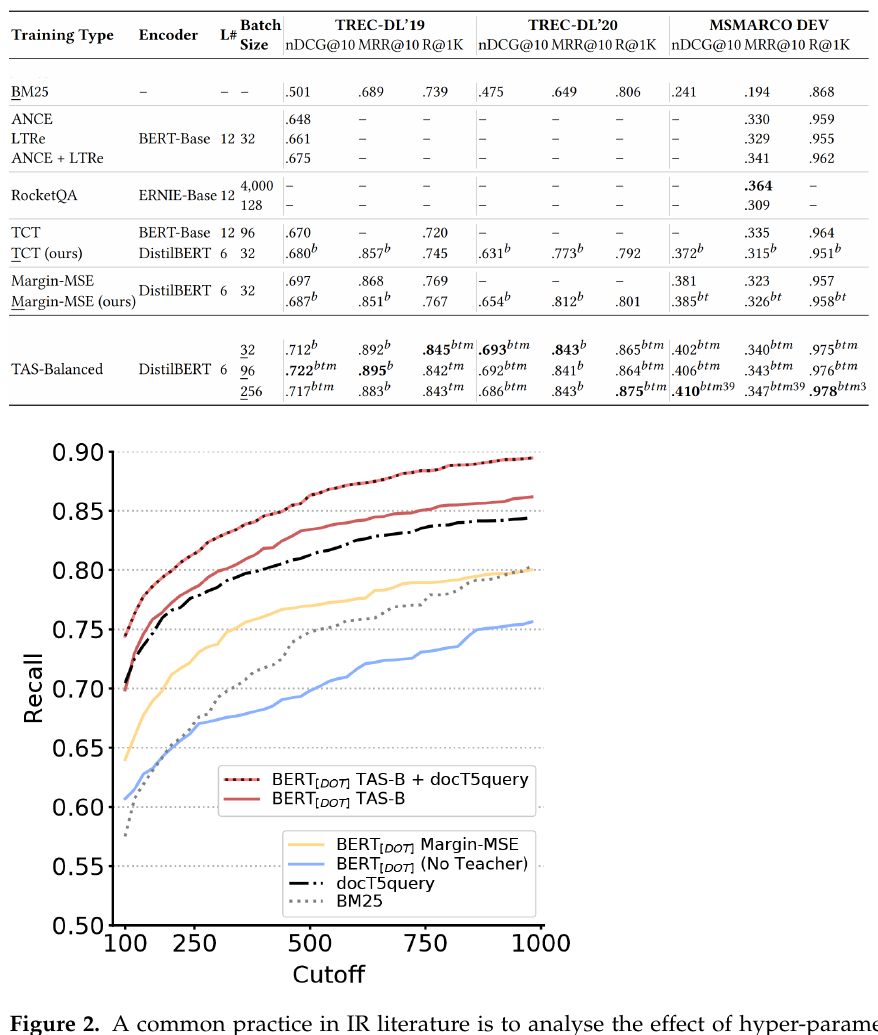
Figure 2. A common practice in IR literature is to analyse the effect of hyper-parameters on the overall system effectiveness and to present the results under the form of tables or graphs. The top part of this figure is a typical table that represents hyper-parameters or comparison of methods. Here, a deep learning-based model was used and comparisons are reported on the different training types, encoders, and batch sizes; using different effectiveness measures (nDCG@10, MRR@10, and results are highlighted in bold font. the bottom part is a typical graph to compare different variants or hyper-parameters effect on effectiveness. Here, the lines represent different combination of hyper- parameters, effectiveness is measured in terms of recall (Y-axis) for different cut-off of the retrieved document list. Table and Figure adapted with permission from [29], Copyright 2021, Sebastian Hofstätter et